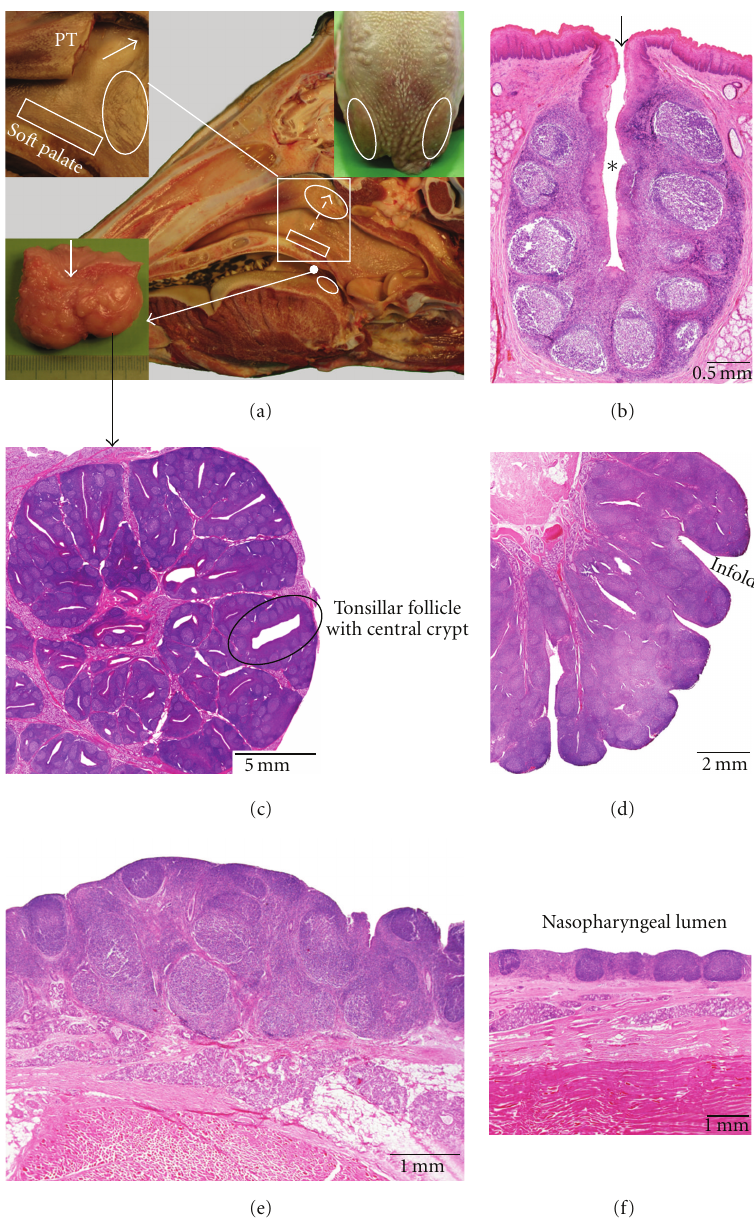
Figure 3: Anatomical localization and histological characteristics of the bovine tonsils. (a) Median section through a bovine head. In the upper left insert, the caudal part of the pharyngeal tonsil (PT, encircled in the central image) has been partly removed to demonstrate the tubal tonsil (encircled in the insert, indicated by the interrupted arrow in the central image) caudoventral to the opening of the auditory tube (arrow in the insert). The tonsil of the soft palate (boxed area) is located at the nasopharyngeal side of the soft palate. The bilobated palatine tonsil is shown in the lower left insert. Its sinus is indicated by the arrow. The position of the lingual tonsil at the root of the tongue is presented in the upper right insert. (b) Histological section through a tonsillar follicle belonging to the lingual tonsil. The tonsillar fossula and crypt are indicated by the arrow and the asterisk, respectively. (c–f) Histological sections through parts of the palatine (c), pharyngeal (d) and tubal (e) tonsils, and the tonsil of the soft palate (f),